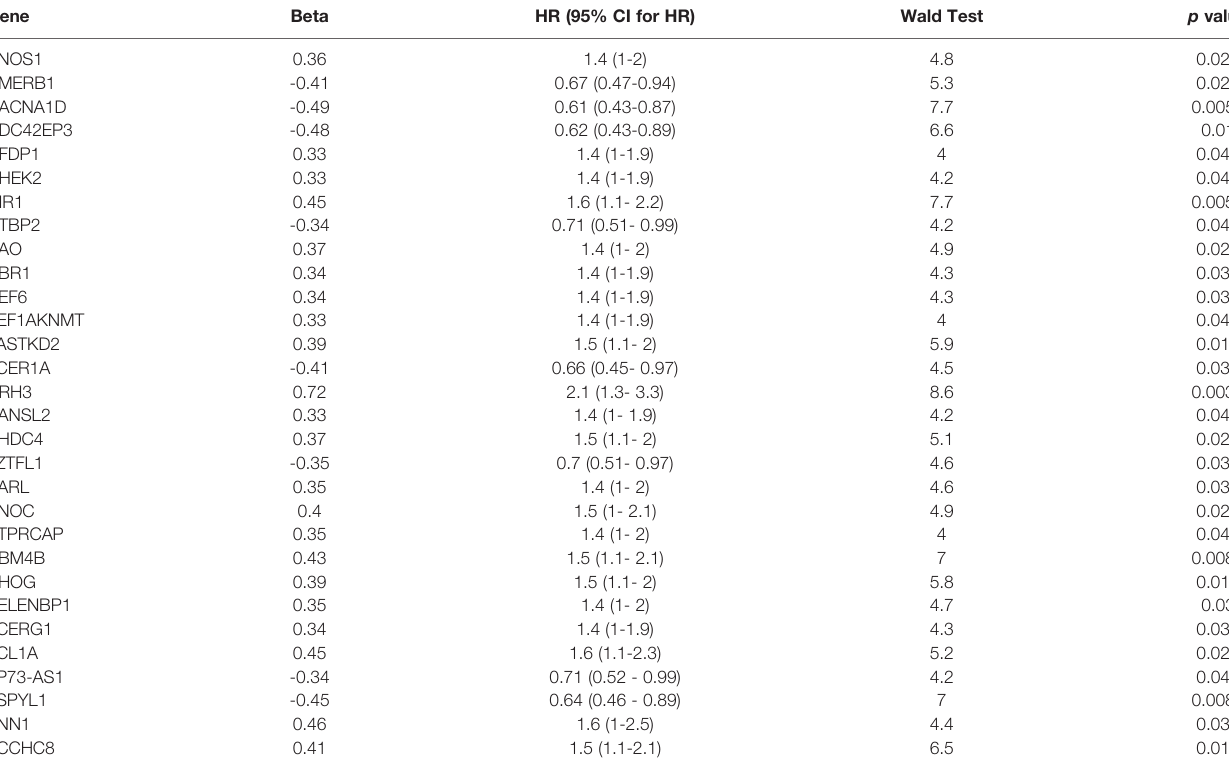
TABLE 2 | A total of 30 potential prognosis-related genes were screened by univariate analysis. Gene Beta HR (95% CI for HR) Wald Test p value ANOS1 0.36